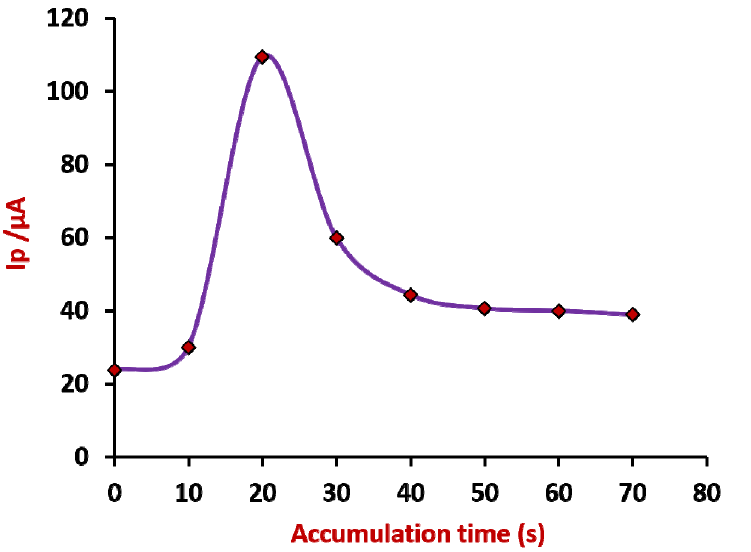
Figure 3. Graphical representation of accumulation time of CIP at pH 4.2 (PBS) at SDS ∙ Gr/CPE.